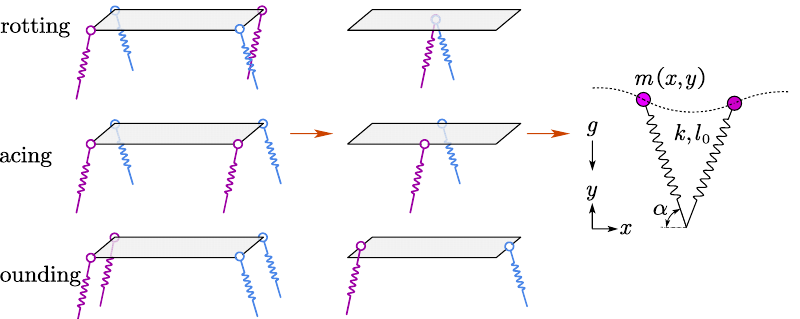
Figure 1. The SLIP model for quadruped robots. The four legs of a robot moving at trotting, pacing, or bounding gait can be simplified as a single equivalent virtual leg by seeking synergies and symmetries. The stiffness of virtual leg k in SLIP model roughly equals that of the quadruped robot, and the point mass m at the CoM is about half the body mass of the robot moving at a symmetrical